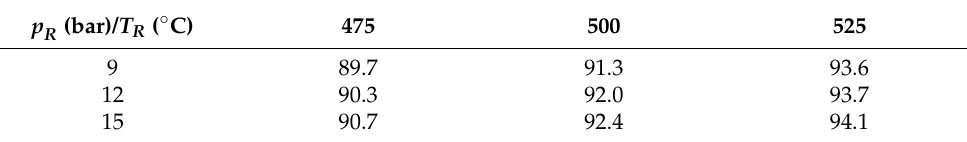
Table 4. Maximum HRF for different reactor temperatures and pressures to guarantee enough thermal power for feed